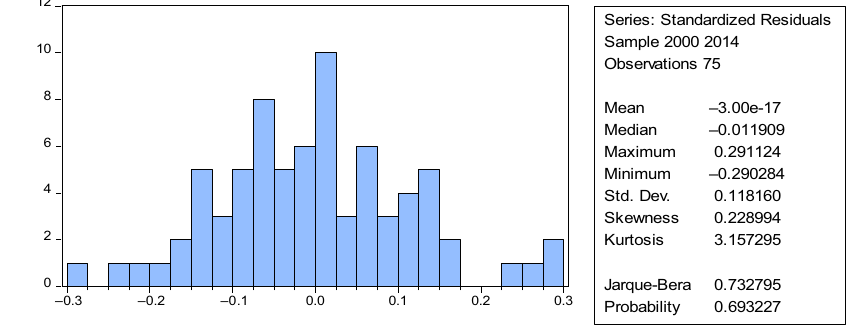
Figure 1. Results of normality